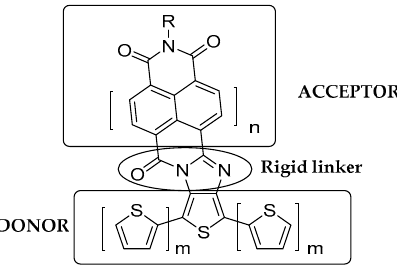
Figure 1. General structure of first generation of thiophene–rylenimide derivatives.